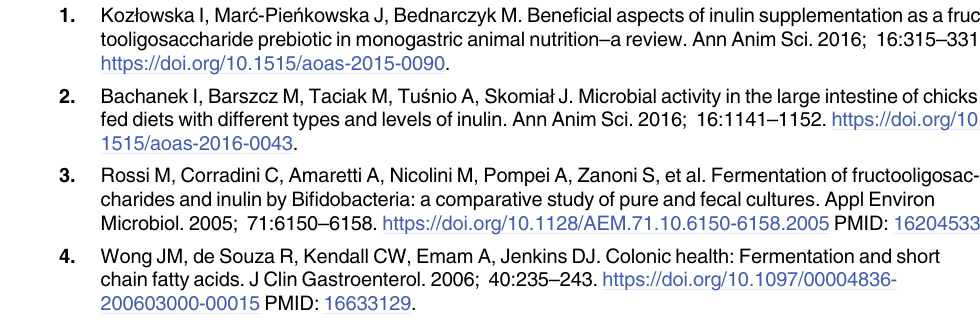
S2 Fig. Pair comparison of the 16S rRNA abundances of top 50 abundant bacterial genera (taxa) identified in the cecal microbiota of chicken fed a basal diet supplemented with 0 (control), 1%, 2% or 4% inulin or 400 ppm bacitracin. (A) Bacitracin treated group vs Con- trol group; (B) 1% inulin treated group vs Control group; (C) 2% inulin treated group vs Con- trol group; (D) 4% inulin treated group vs Control group. P values were determined with Kruskal Wallis test. Symbol labels in (A) also apply to (B), (C) and (D). (PDF) S1 Table. Relative abundance of bacterial genera (taxa) identified in the cecum of broiler chickens fed a corn-based diet supplemented with 0 (control), 1%, 2%, or 4% inulin or 400 ppm bacitracin. S2 Table. Relative expression abundance of assigned proteins in the cecal microbiota of broiler chickens fed a corn-based diet supplemented with 0 (control), 1%, 2% or 4% inulin or 400 ppm bacitracin. S3 Table. Bacterial relative expression abundance of family 32 glycoside hydrolases in the meta-transcriptome of the cecal microbiota of chickens fed a basal diet supplemented